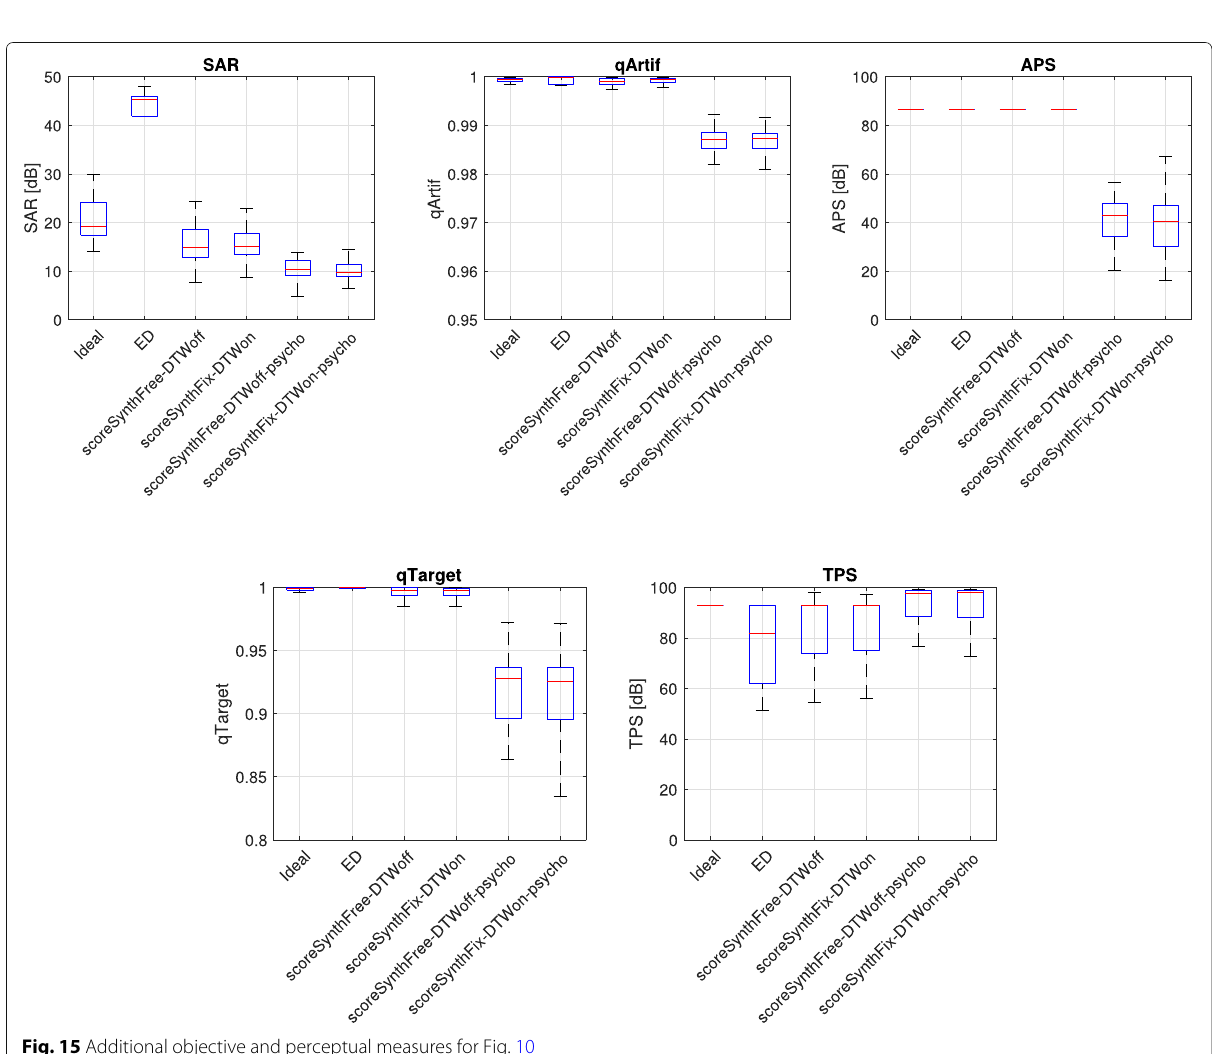
Fig. 15 Additional objective and perceptual measures for Fig.